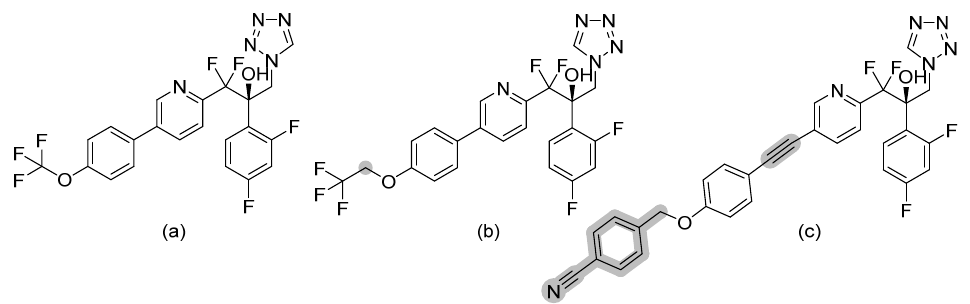
Figure 10. Chemical structures of ( a ) VT-1129, ( b ) VT-1161, and ( c ) VT-1598. Differences in chemical structures are highlighted in grey.